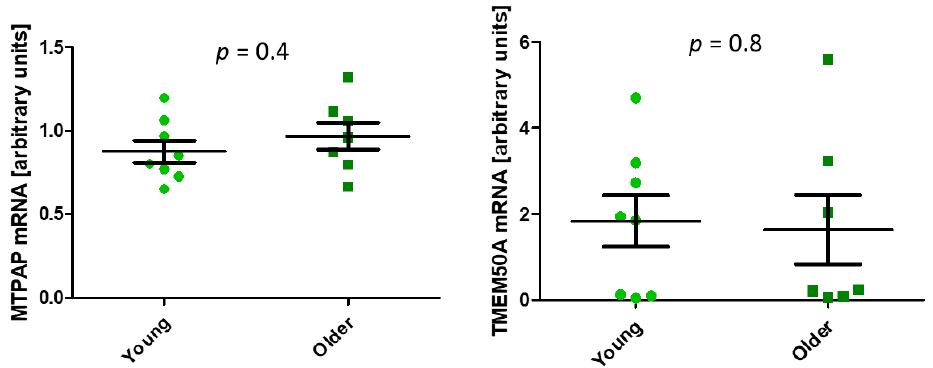
Figure 7. RT-PCR evaluation of mRNA expression of genes associated with age-related differentially hydroxymethylated regions (DHMRs) identified by both DiffBind and MEDIPS algorithms and both wide (approximately 450 bp) and narrow (50 bp) window sizes. The statistical analysis was performed with the Student’s t -test. Young (22–35 years), older (74–94 years).